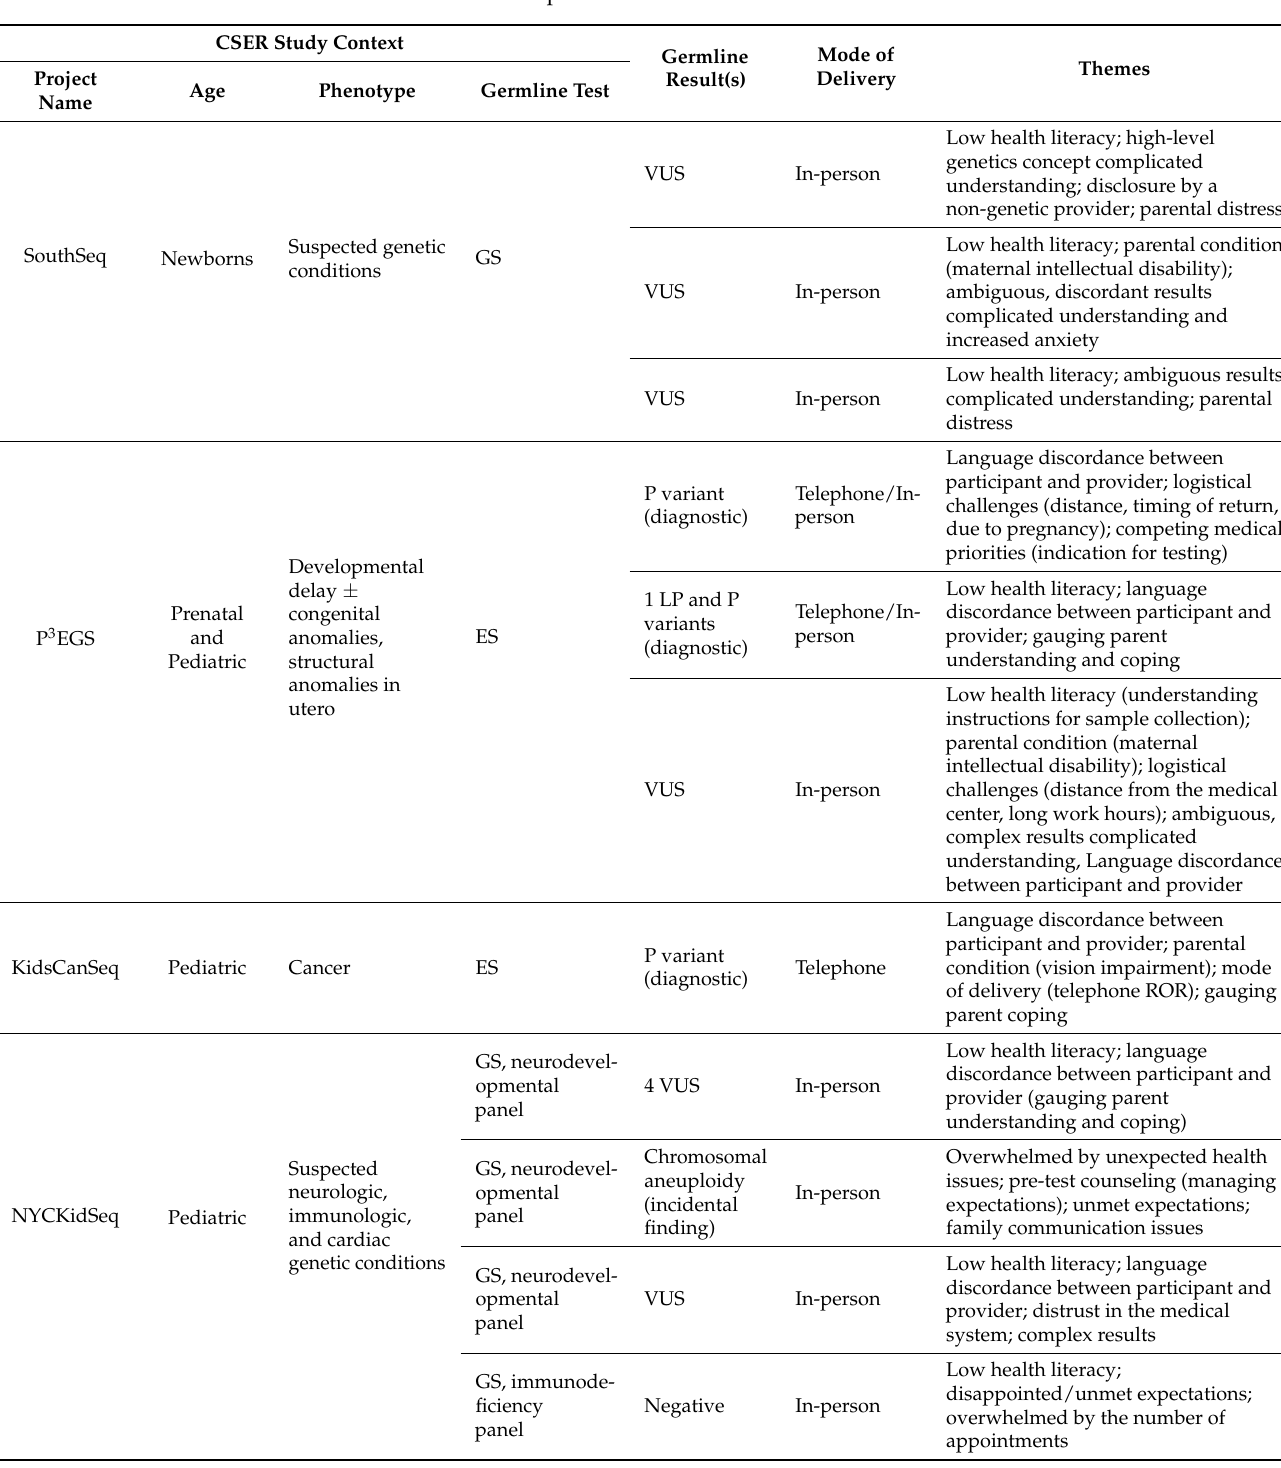
Table 1. Description of cases with related